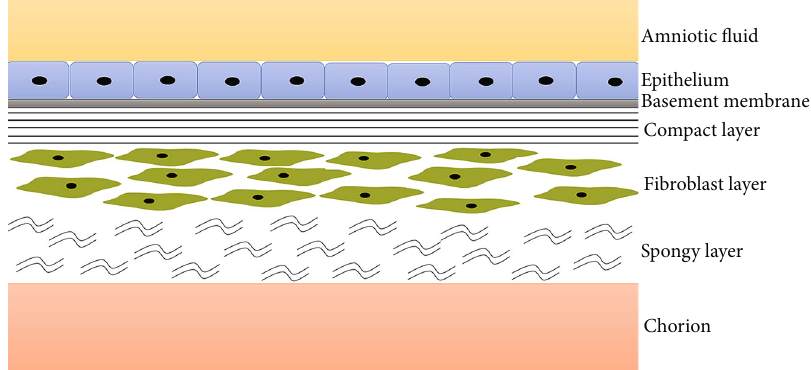
Figure 1: Schematic diagram of the amnion. The amnion consists of fi ve histological layers, namely, epithelial monolayer, basement membrane, a compact layer, a fi broblast layer, and an intermediate or spongy